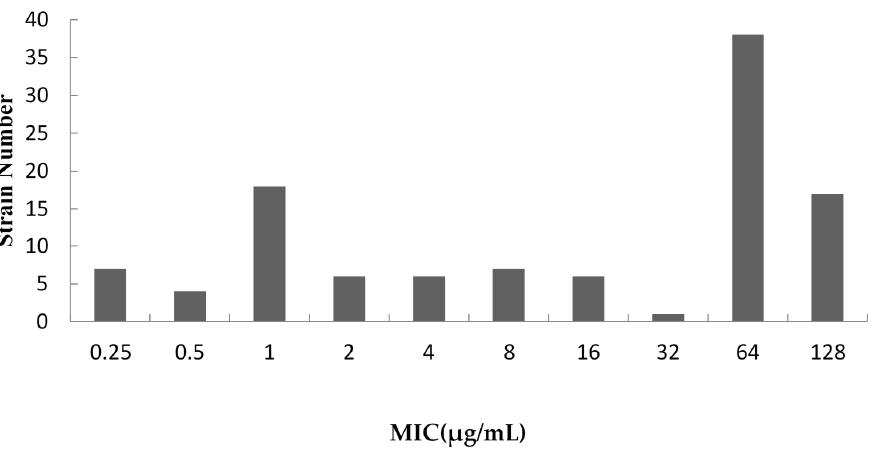
Figure 1. Acetylkitasamycin MIC distribution of 110 S. suis strains isolated. Table 1. Distribution Log 2 MICs and cumulative distribution Log 2 MICs.